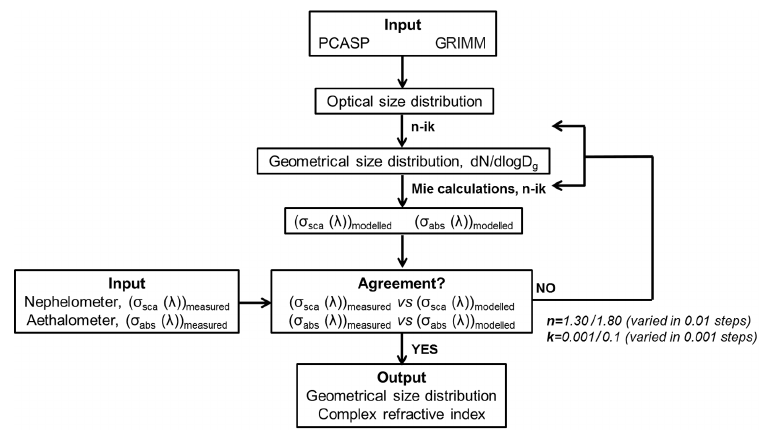
Figure 2. Flowchart of the size distribution and refractive index retrieval procedure. Further details are provided in Sect.